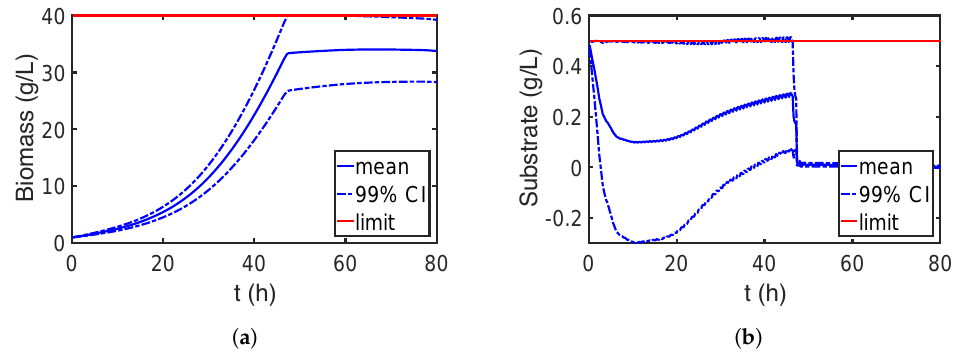
Figure 15. Evolution of the mean and 99% confidence interval (CI) of the ( a ) biomass and ( b ) substrate concentrations for the robust design of the fed-batch bioreactor, where the uncertain parameters are independent. The feeding profile from the robust design with independent uncertain parameters is applied.